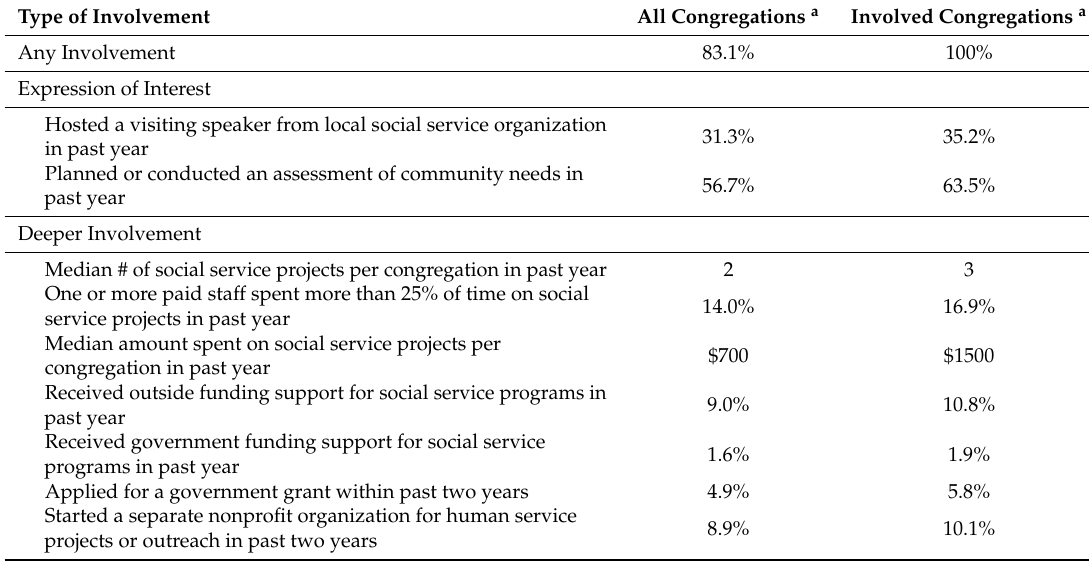
Table 1. Involvement in social services by religious congregations in the USA,